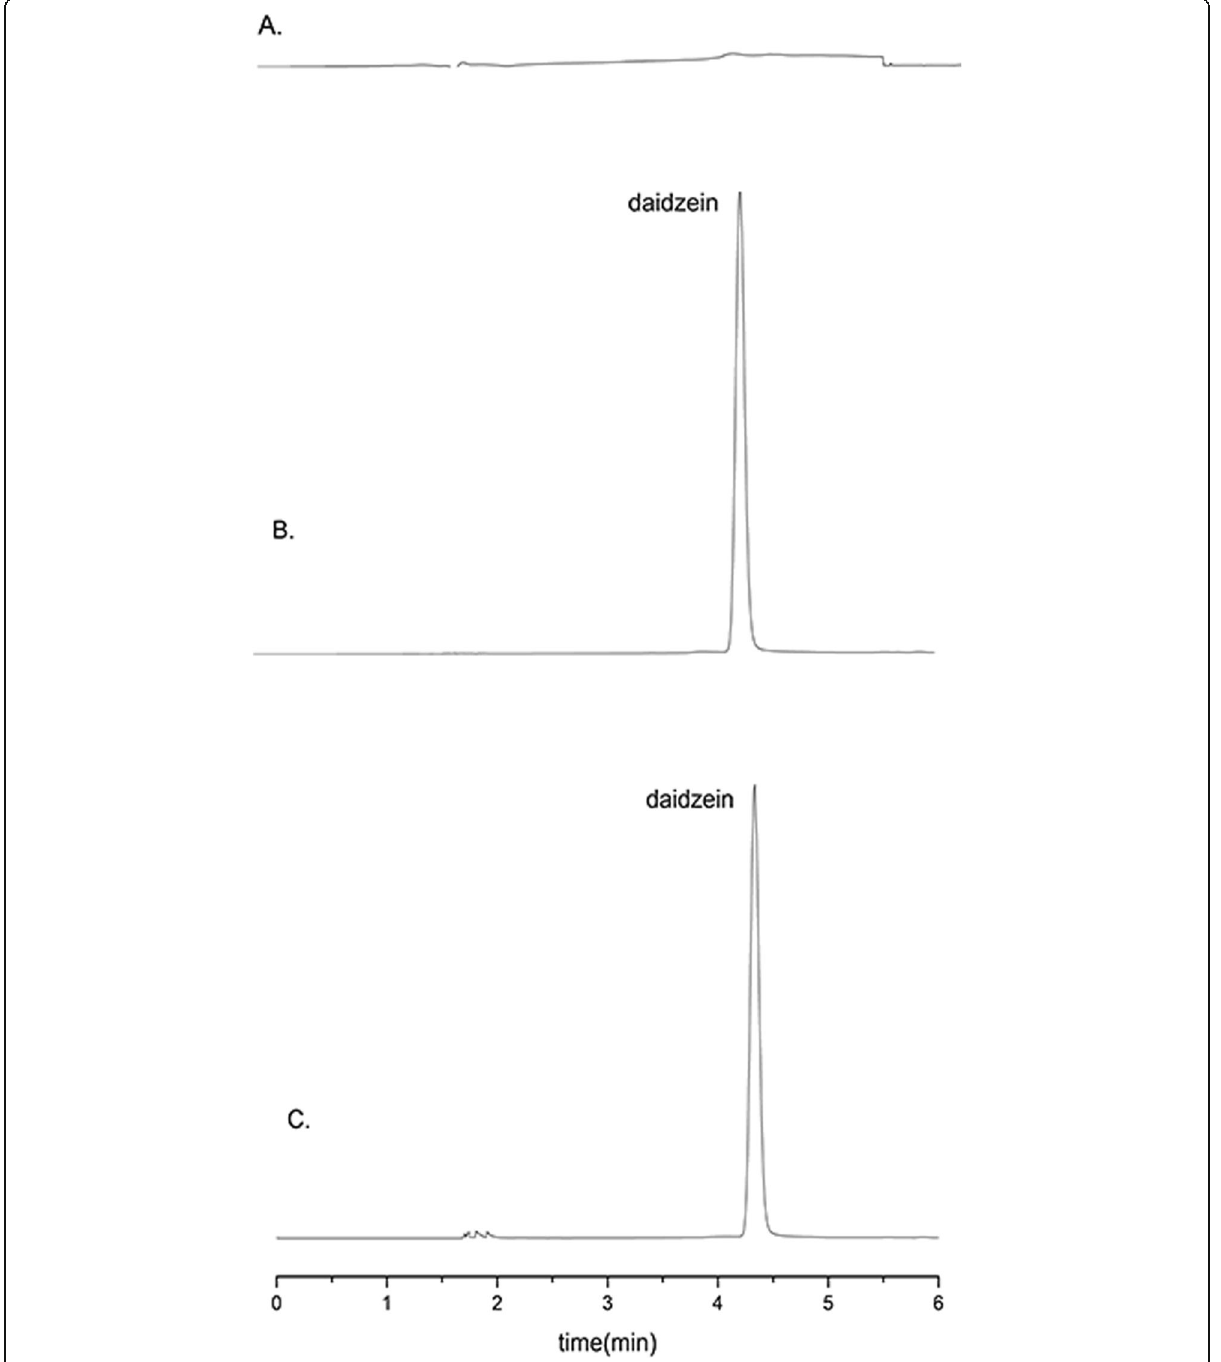
Fig. 1 Typical chromatograms of blank liposomes ( a ), daidzein reference substance ( b ), and DLCL sample ( c